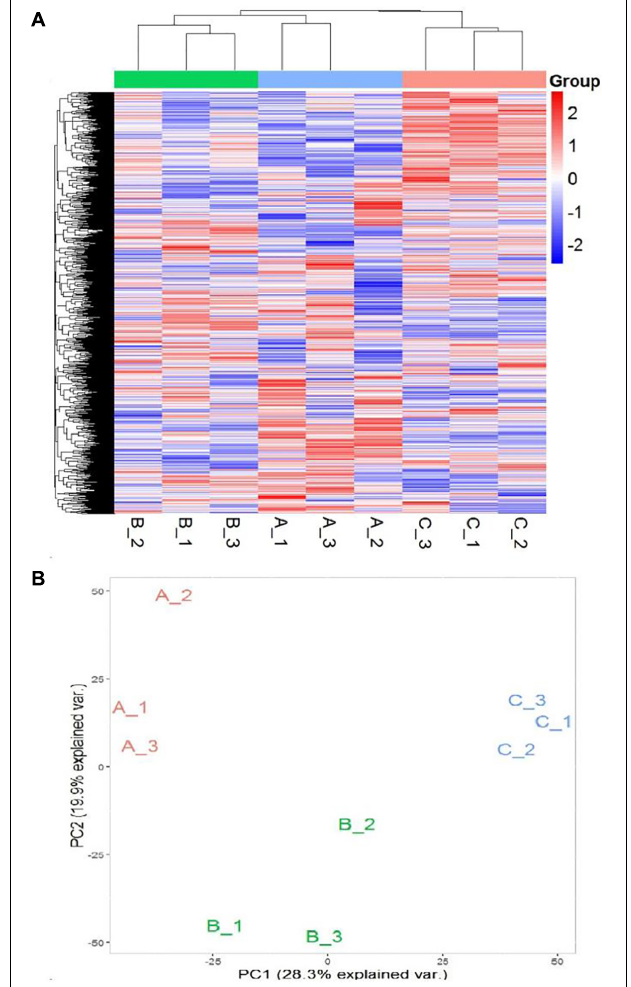
FIGURE 5 | (A) Heat map representation of DEPs (A1–A3: 0 mM NaCl; B1-B3: 100 mM NaCl, C1–C3: 300 mM NaCl). (B) Principal Component Analysis (PCA) of the proteome data in a 2D graph of PC1 and PC2. The plot shows the treatment effect (loadings) for the control (A1–A3), low (B1–B3), and high (C1–C3)